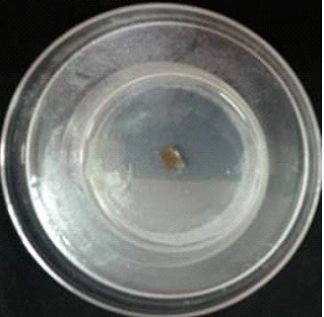
Fig. 9 (a). Mycelial growth of Rhizopus stolonifer After adding 5 ml of Fes (in the outer dish) and incubation for one week at 27°C